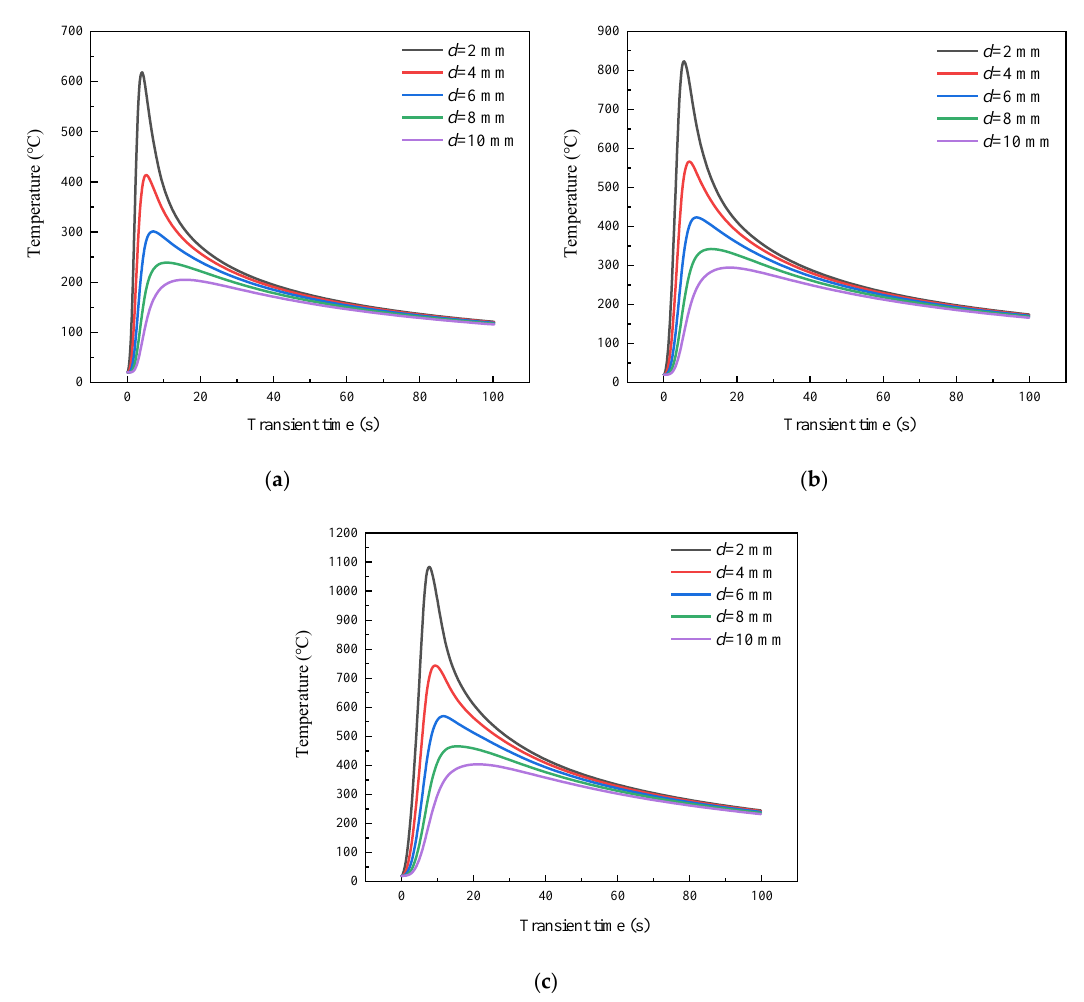
Figure 24. Thermal cycle curves at crack tips in the HAZ for three different linear energy values: ( a ) Q = 10 kJ/cm; ( b ) Q = 16 kJ/cm; ( c ) Q = 25 kJ/cm.